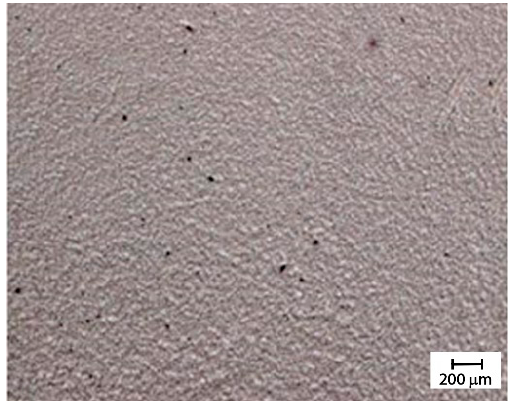
Figure 14. Optical micrograph of the dispersion obtained with the mixed method.